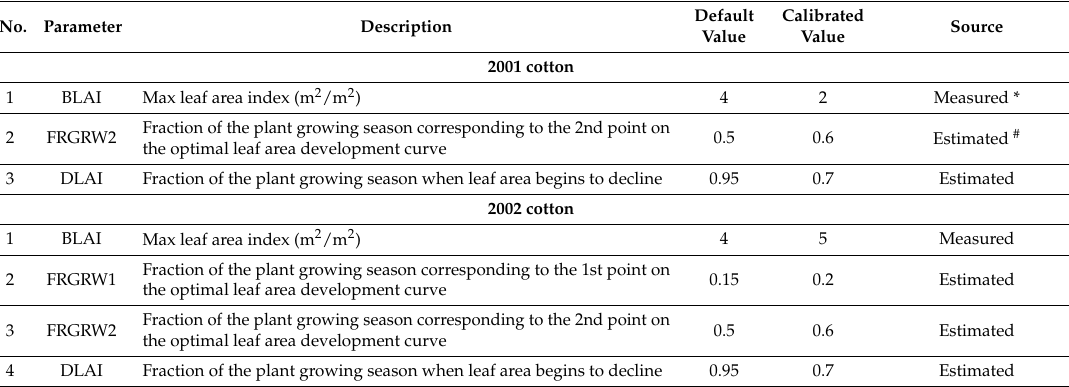
Table 4. Default and calibrated values of crop parameters in Soil and Water Assessment Tool